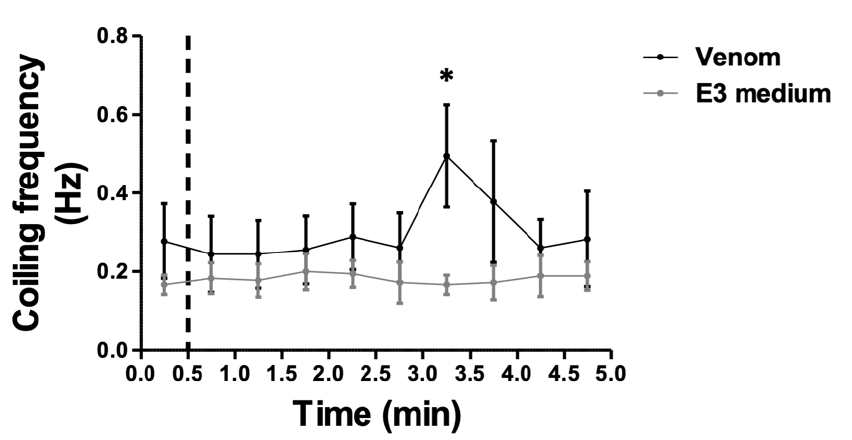
Figure 3. Neurotoxicity of M. bornmuelleri’s venom . The effect of M. bornmuelleri ’s venom (1 mg/mL) on one-day-old embryos’ tail coiling frequency. Baseline coiling activity was recorded for 30 s before addition of the venom (dashed line). E3 medium was used as the negative control. * p ≤ 0.05; N = 6 per condition.